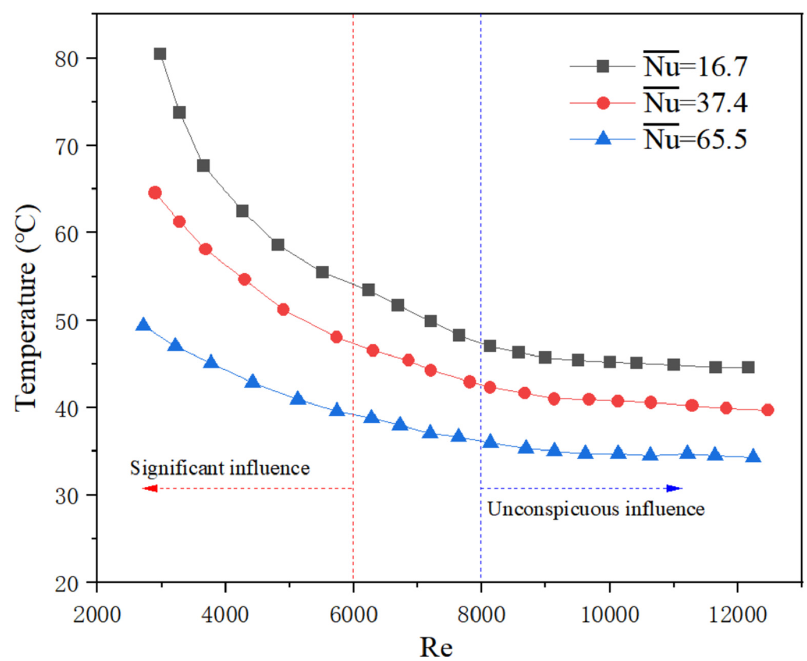
Figure 14. Temperature rise to flow fluctuation at different heat transfer intensity.